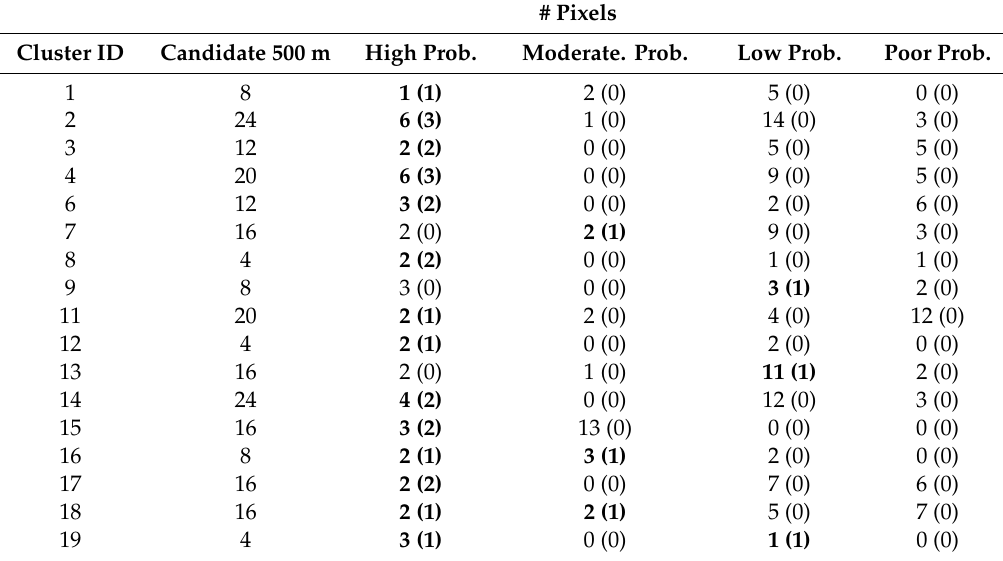
Table 2. Algorithm assessment results. Column 2 shows the number of 500 m candidate pixels that were encompassed by the 1 km detection. Columns 36—show the number of 500 m pixels assigned probability class High, Moderate, Low, and Poor using the downscaling algorithm. Values in parenthesis indicate the number pixels with an evident flare (active and inactive flare stack). # Pixels Cluster ID Candidate 500 m High Prob. Moderate. Prob. Low Prob. Poor